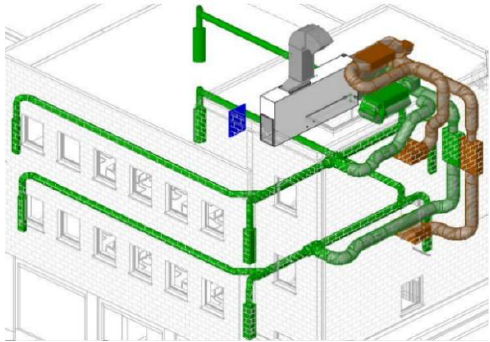
Figure 3. Ventilation system (supply in green, return in brown) of the test lecture rooms on KU Leuven Technology campus Ghent.